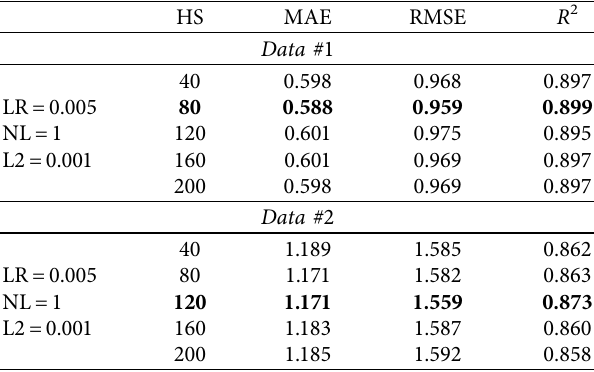
Te bold values means the best results in the data set. Table 2: Predictive performance comparison with diferent initial learning rates.